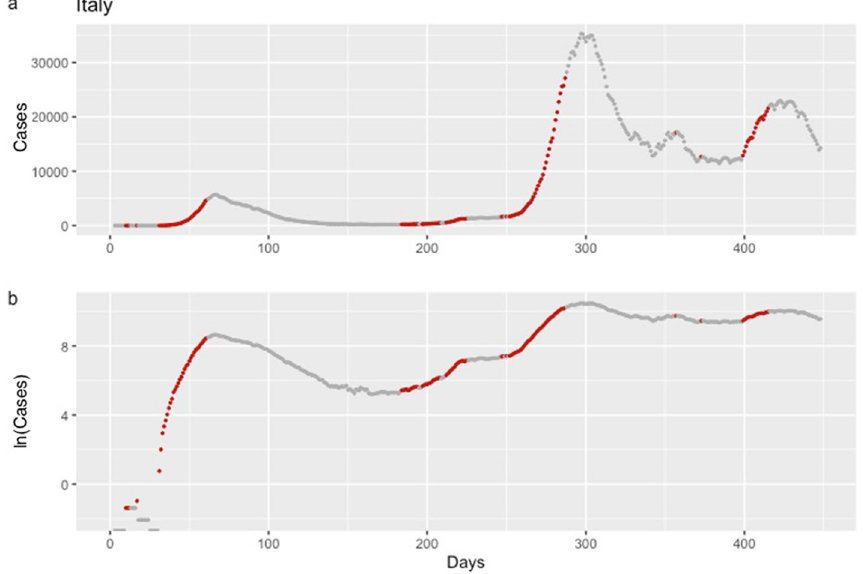
Figure 3. Daily confirmed cases of COVID-19 in Italy, from January 22, 2020, until April 13, 2021. Analysis is based on the criterion aiming to detect an increase in the mean of expected cases equal or higher than 20%. Red dots correspond to dates that, according to the Epidemic Volatility Index (EVI), an early warning was issued indicating that a rise in the COVID-19 cases is expected. Data are presented on the original scale ( 1a ) and the logarithmic scale ( 1b ), which facilitates the comparison of the steepness of the epidemic curve between the different